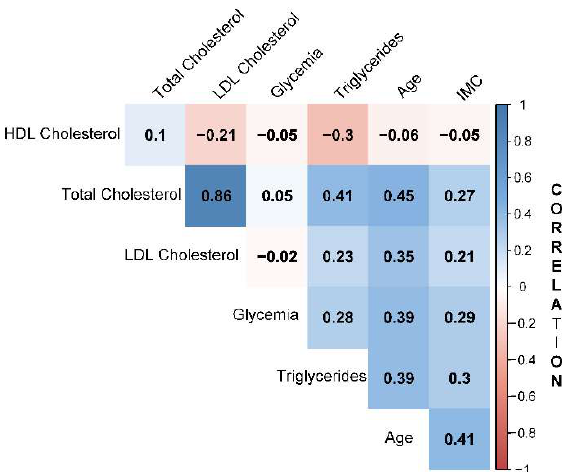
Figure 2. Correlation of explanatory